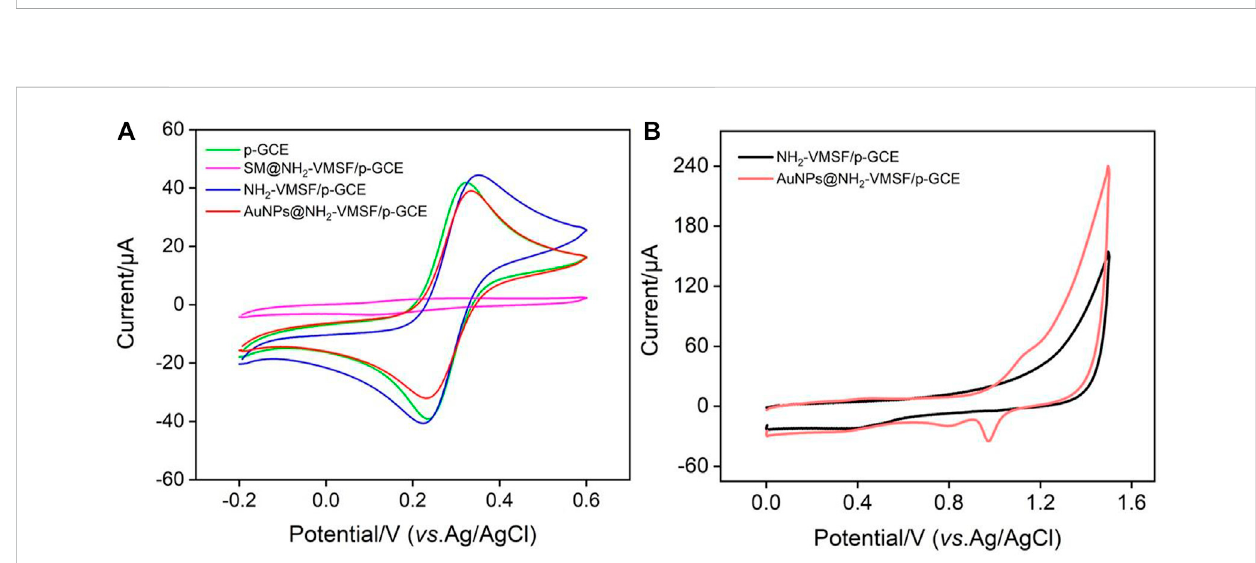
FIGURE 2 (A) Cyclicvoltammetry(CV)curvesobtained ondifferentelectrodesinKCl(0.1 M)containingFe(CN)